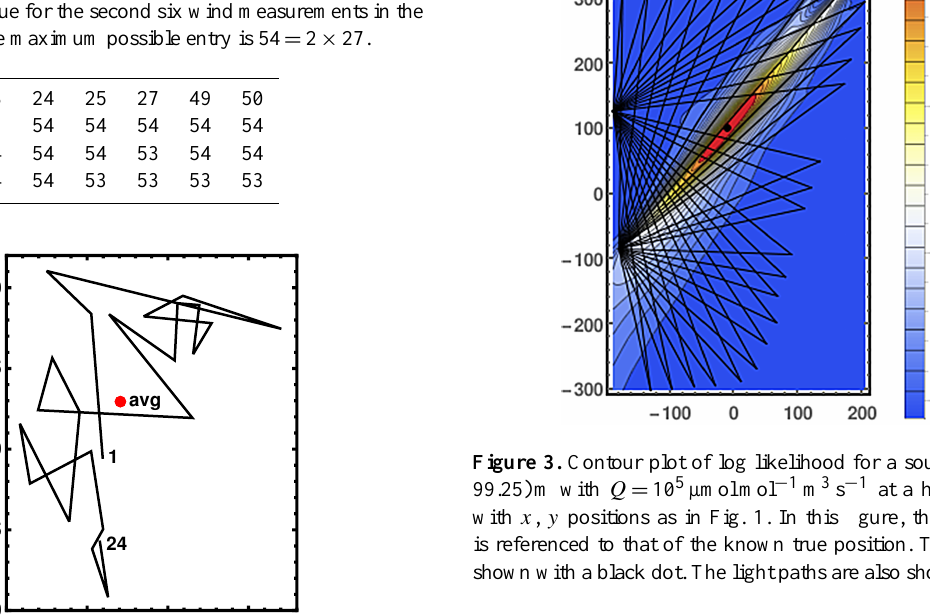
Table 2. Number of optical observations for each wind measure- ment, with the value for the first six wind measurements given in the first row, the value for the second six wind measurements in the second row, etc. The maximum possible entry is 54 = 2 × 27.